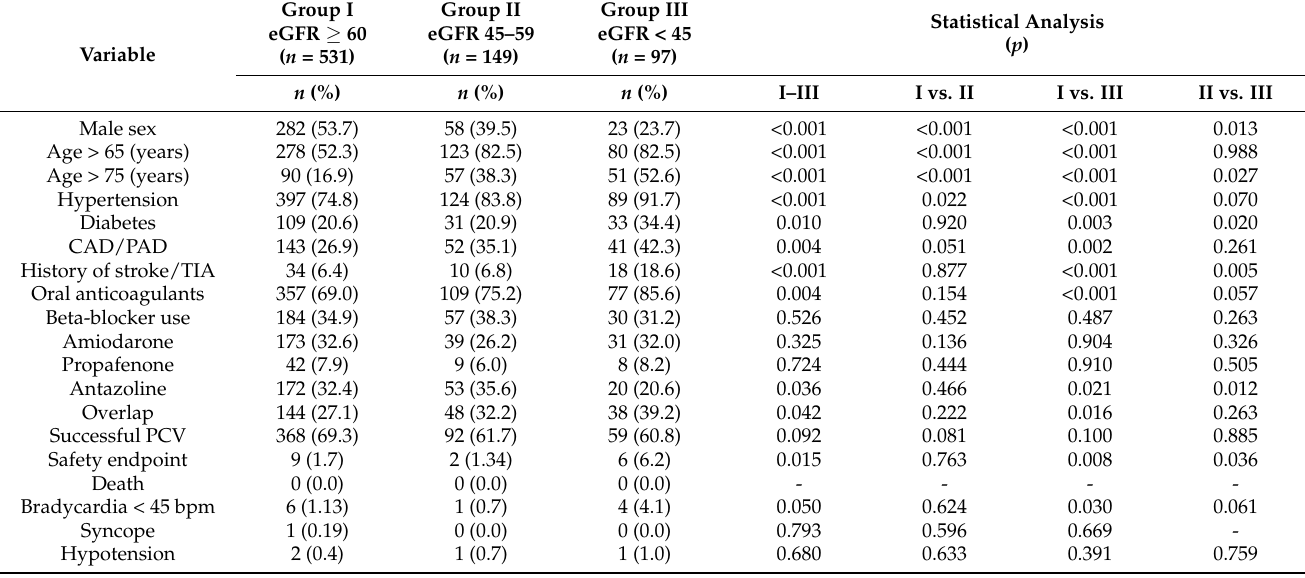
Table 1. Clinical characteristics of studied patients depending on the stage of chronic kidney disease (CAD—coronary artery disease; PAD—peripheral artery disease; TIA—transient ischaemic attack; eGFR—estimated glomerular filtration rate; BMI—body mass index; CHA 2 DS 2 -VASc—scoring system estimating a risk of stroke in patients with AF; EHRA—European Heart Rhythm